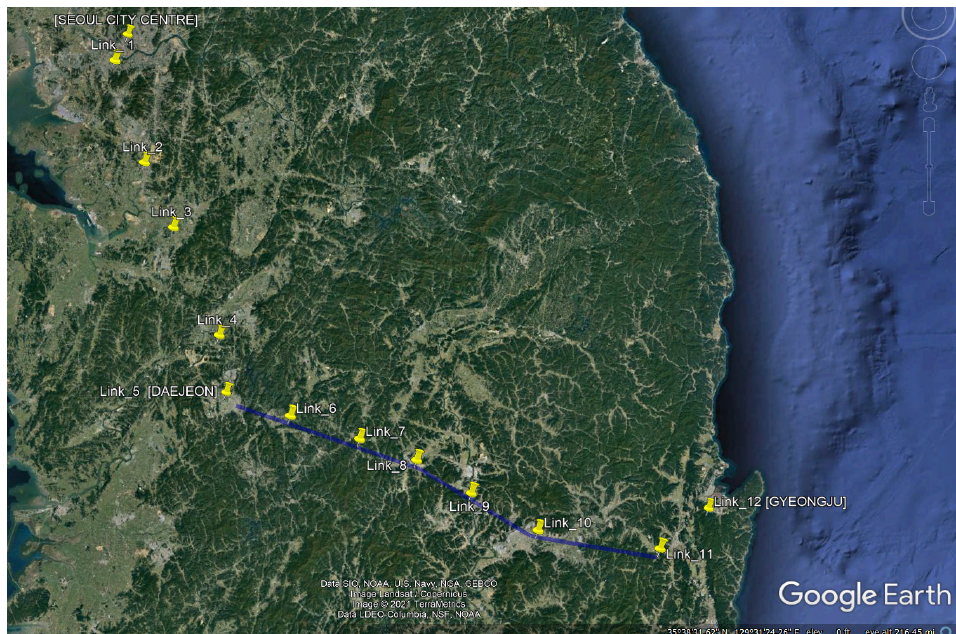
Figure 3. Route segments between Seoul to Gyeongju.